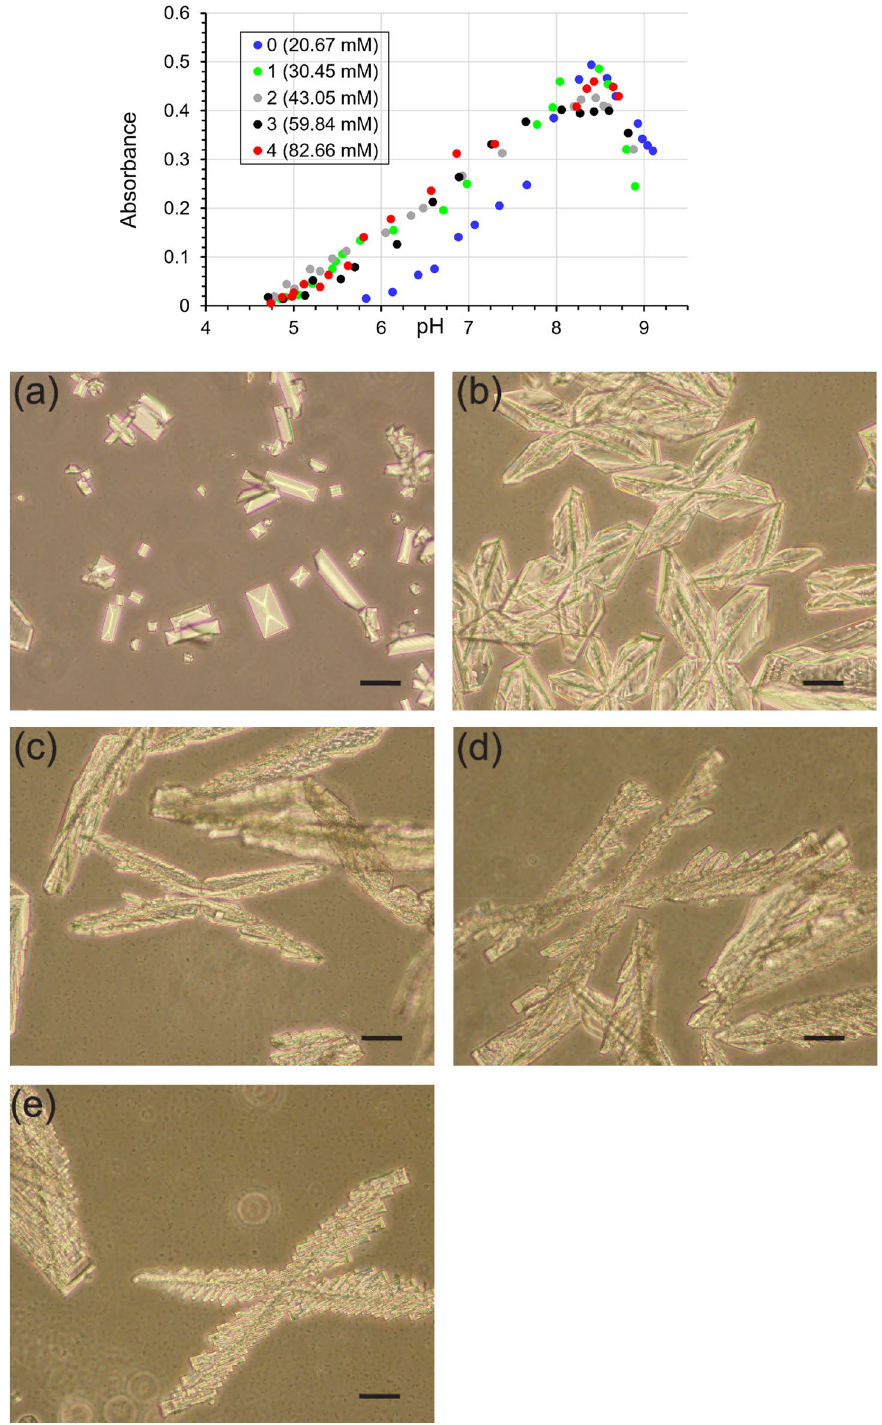
Figure 10. Absorbance (measured at a wavelength of 600 nm) of artificial urine versus pH for various P concentrations (top row) in the presence of bacteria (after the initial urine pH has been raised to approximately 4.7). Habit of struvite crystals in the control system (baseline)—( a ), and for concentration 1 ( b ), 2 ( c ), 3 ( d ) and 4 ( e ), 24 h after adding bacteria to urine. Scale bar 40